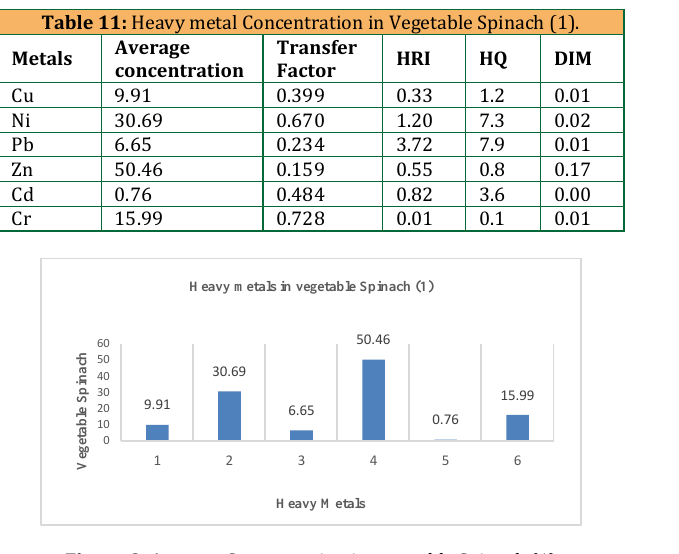
Figure 8: Average Concentration in vegetable Spinach (1)